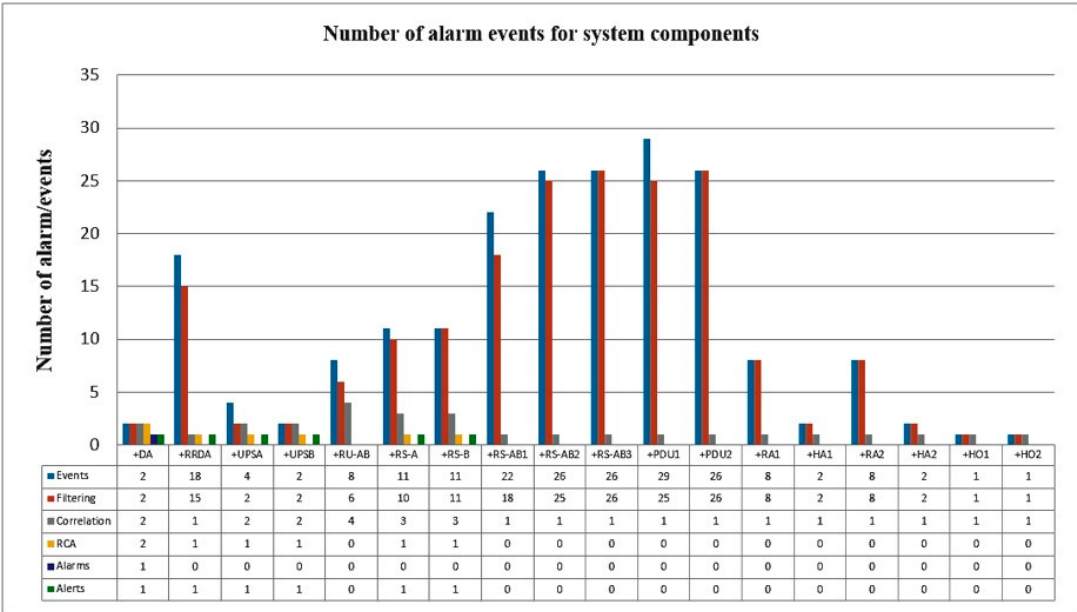
Figure 4. Comparison of the events numbers.